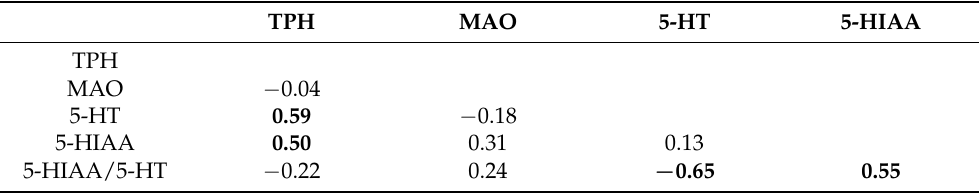
Table 2. Pearson’s correlation coefficients between the TPH, MAO activities, the 5-HT and 5-HIAA levels and the 5-HIAA/5-HT turnover rate in the brain of 2-, 4- and 7-month-old male and female N. furzeri . TPH MAO 5-HT 5-HIAA TPH MAO − 0.04 5-HT 0.59 − 0.18 5-HIAA 0.50 0.31 0.13 5-HIAA/5-HT − 0.22 0.24 − 0.65 0.55